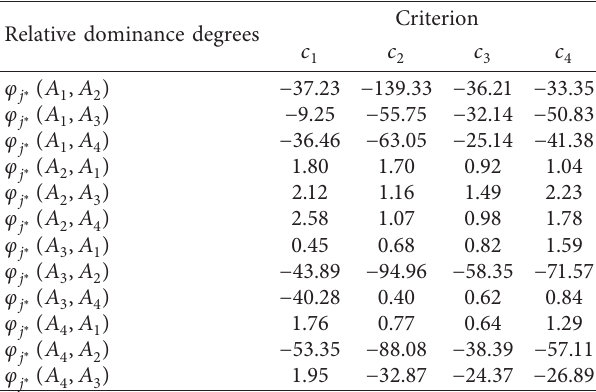
Table 4: Relative prospect dominance degrees under each